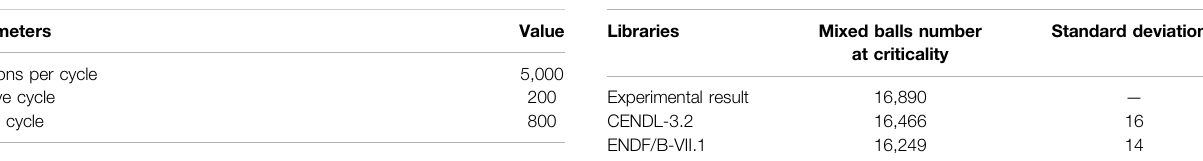
TABLE 1 | Calculation parameters of initial criticality. TABLE 2 | Comparison of initial criticality